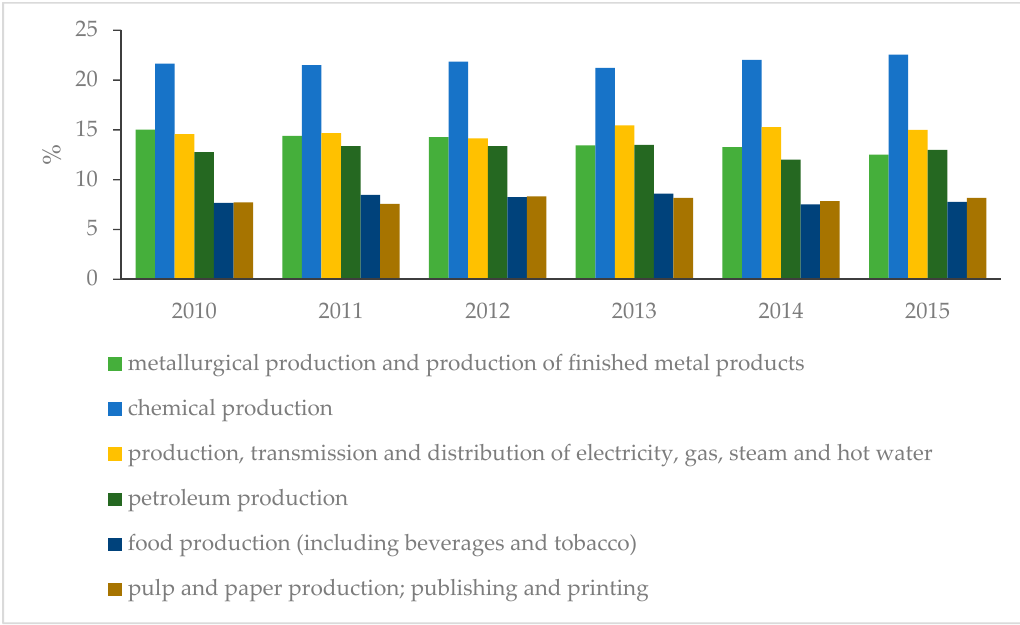
Figure 12. Industries in the Krasnodar Region leading in the consumption of thermal energy. Source: Statistical Digest Industrial “Production in Russia—2016”, Part 5.4 “Consumption of certain types of fuel and energy resources by type of economic activity” https://gks.ru/bgd/regl/b16_48/Main.htm [18].